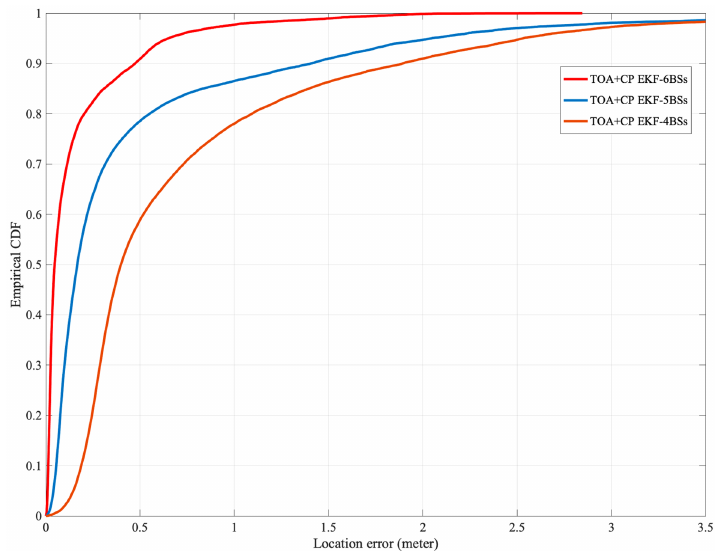
Figure 10. The CDF of horizontal localization error with differfent number of